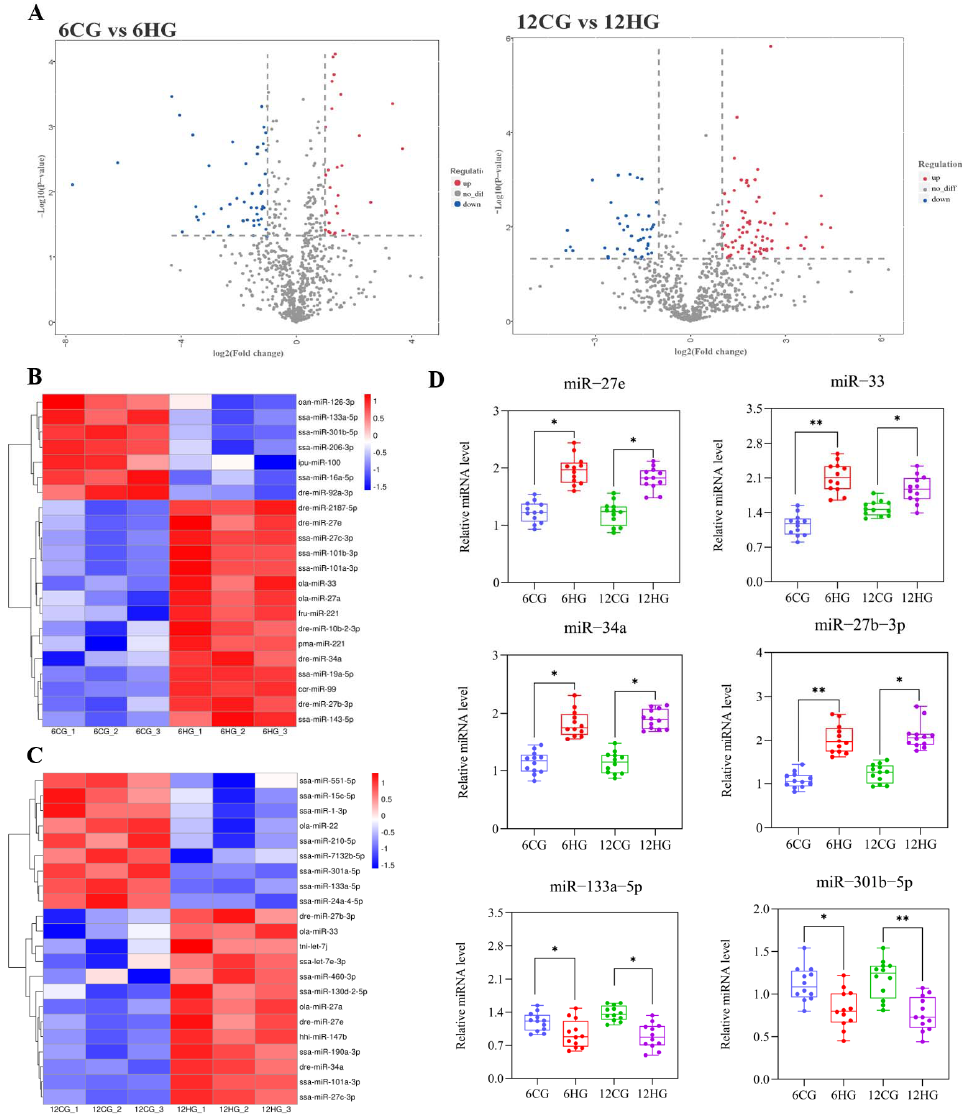
Figure 3. Differentially expressed miRNA screening and validation of Nile tilapia ( Oreochromis niloticus ) ovary under heat stress. Note: ( A ) Number of differentially expressed miRNAs. RNA from four samples was mixed to construct each sequencing library: 12 sequencing libraries were constructed, three 6 d control groups (6CG_1, 6CG _2, 6CG _3) vs. three 6 d heat-stressed groups (6HG_1, 6HG_2, and 6HG_3), and three 12 d control groups (12CG_1, 12CG _2, 12CG _3) vs. three 12 d heat-stressed groups (12HG_1, 12HG_2, and 12HG_3). ( B , C ) Heatmap analysis of differentially expressed miRNAs identified from miRNA-Seq data. ( D ) Validation of differentially expressed miRNAs by qRT-PCR ( n = 12). * indicates statistical significance between heat-stressed group and control group ( p < 0.05). ** indicates a statistically very significant difference between heat-stressed group and control group ( p < 0.01). ns indicates no statistical